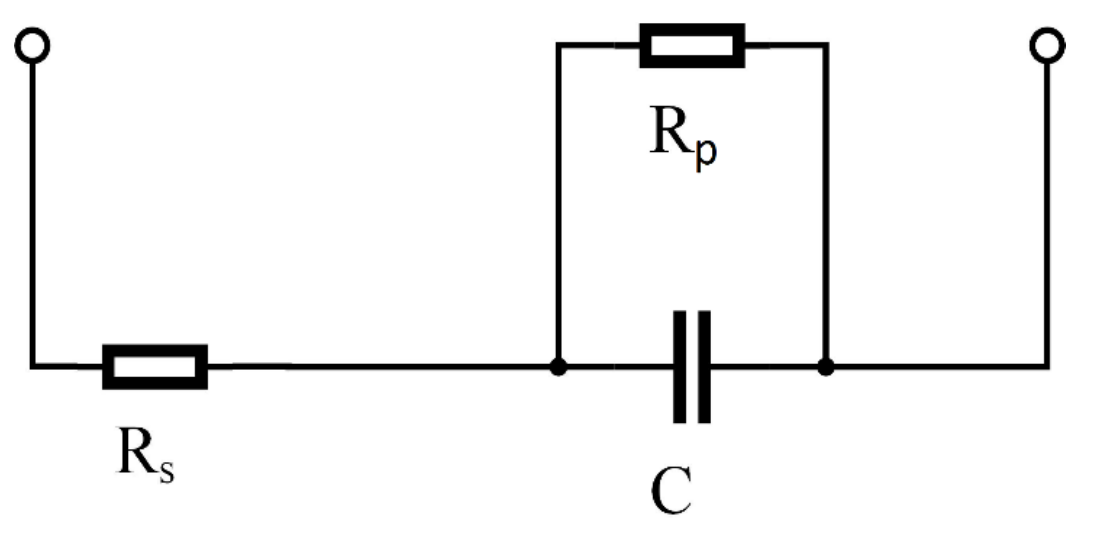
Figure 2. Equivalent circuit of a supercapacitor